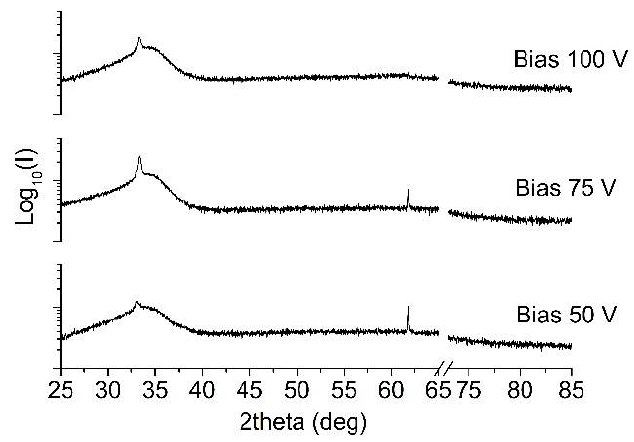
Figure 4. XRD patterns of TaN films deposited at different bias voltages.